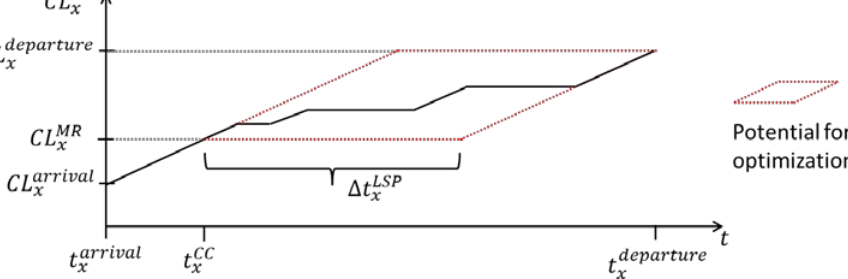
Figure 1. Plug-in electric vehicle (PEV) charging event x with load-shifting potentials. Plug-in times ∆ t